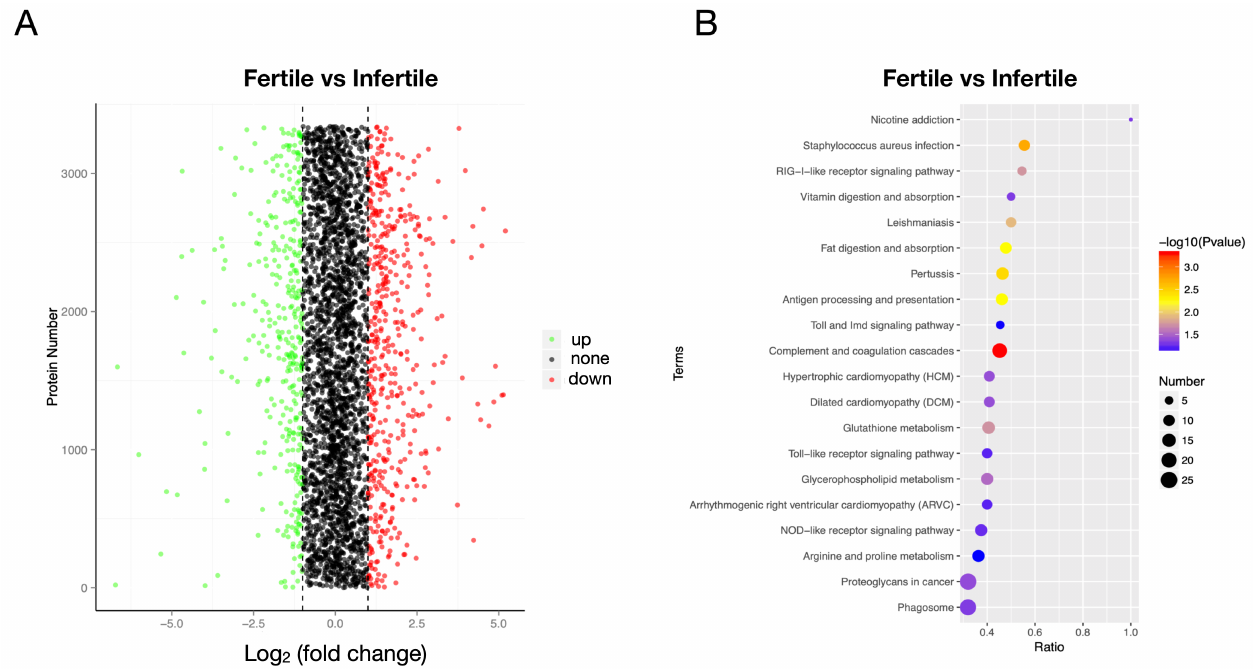
Figure 8. Volcano plot and pathway analysis of differentially expressed proteins (DEPs) between infertile and fertile group in Paralichthys olivaceus . ( A ) Volcano plot of DEPs. The red spots, green spots, and black spots separately represent down-regulated, up-regulated, and undifferentiated proteins. ( B ) Top 20 significantly changed pathways associated with